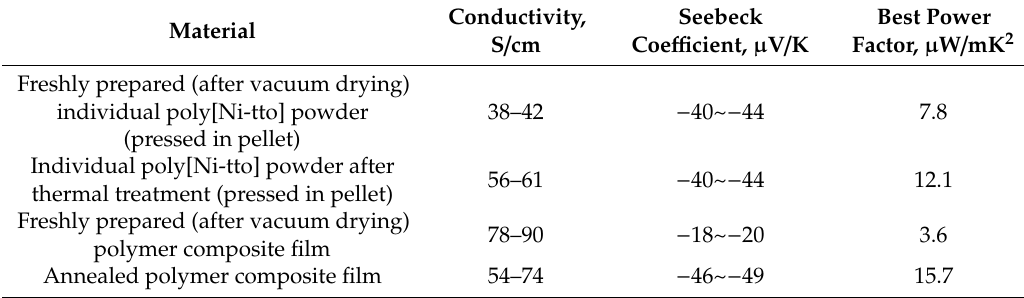
Table 1. Sequential changes in thermoelectrical properties of